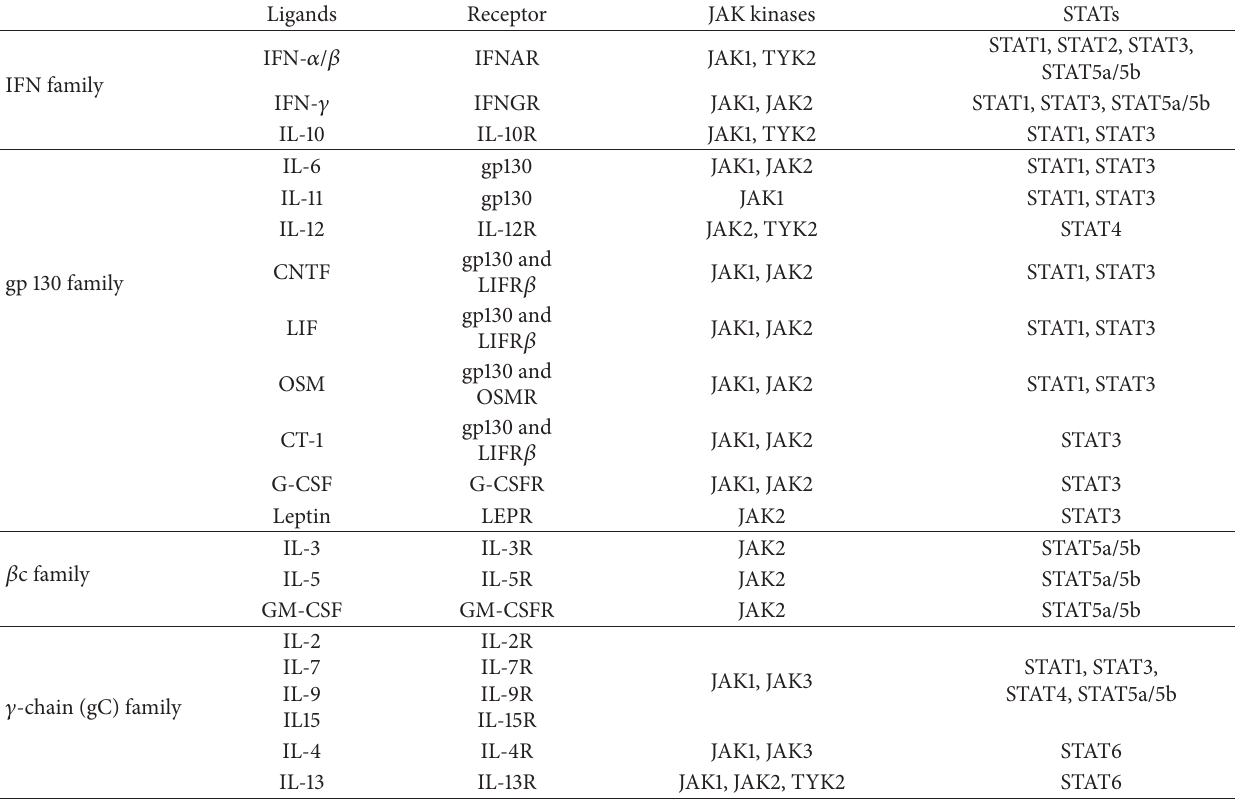
Table 1: Cytokines and their corresponding specific receptors in JAK-STAT signaling